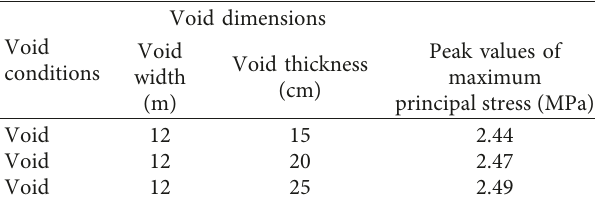
Figure 12: Peak value variation curve for maximum principal stress of the inverted arch: (a) void thickness is 10cm; (b) void width is 4m. Table 7: Peak value of maximum principal stress (in the case of void width of